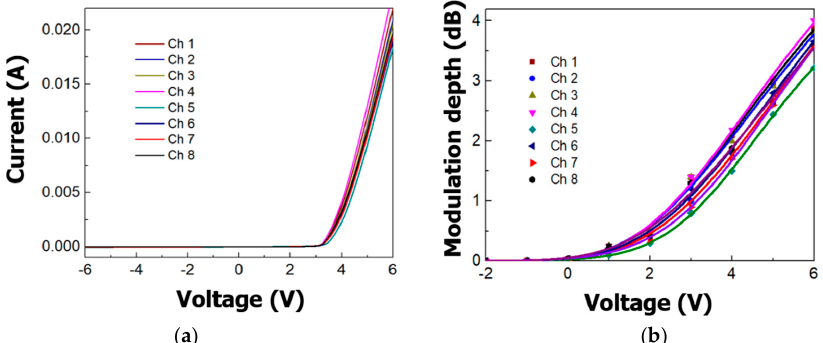
Figure 9. The experimental correlation of current–voltage (I–V) characteristics and modulation depths: ( a ) I–V characteristics; ( b ) modulation depths of the silicon